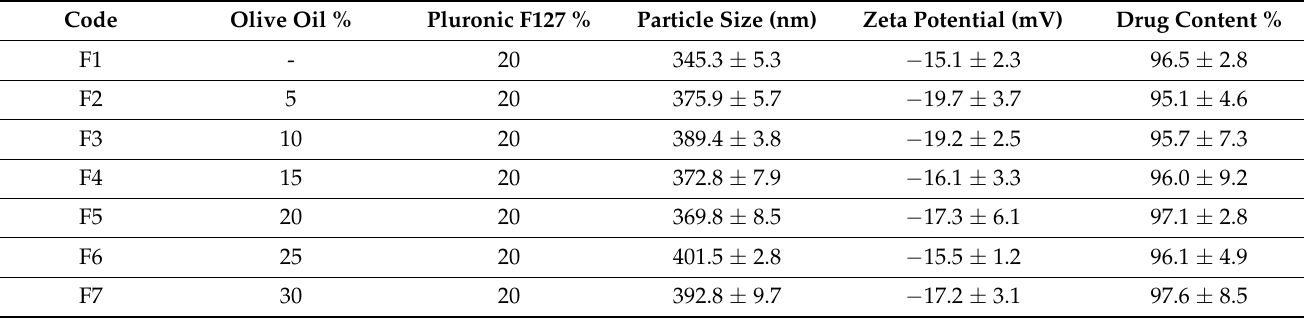
Table 1. Compositions, mean particle size, zeta potential and drug content % (means ± SD, n = 3) of different formulations.